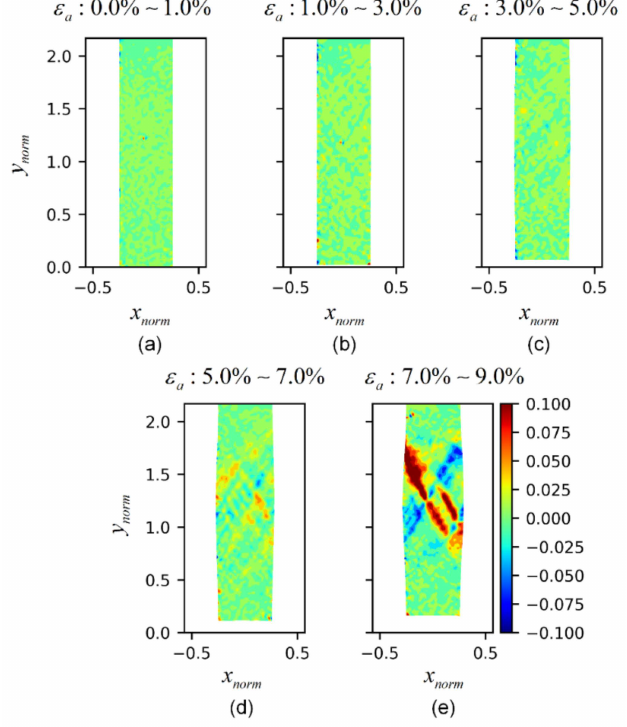
Figure 18. Evolution of curl along ˆ ρ axis ( curl U ) of test 121304c: ( a ) axial strain 0.0%–1.0%; ( b ) axial ρ strain 1.0%–3.0%; ( c ) axial strain 3.0%–5.0%; ( d ) axial strain 5.0%–7.0%; ( e ) axial strain